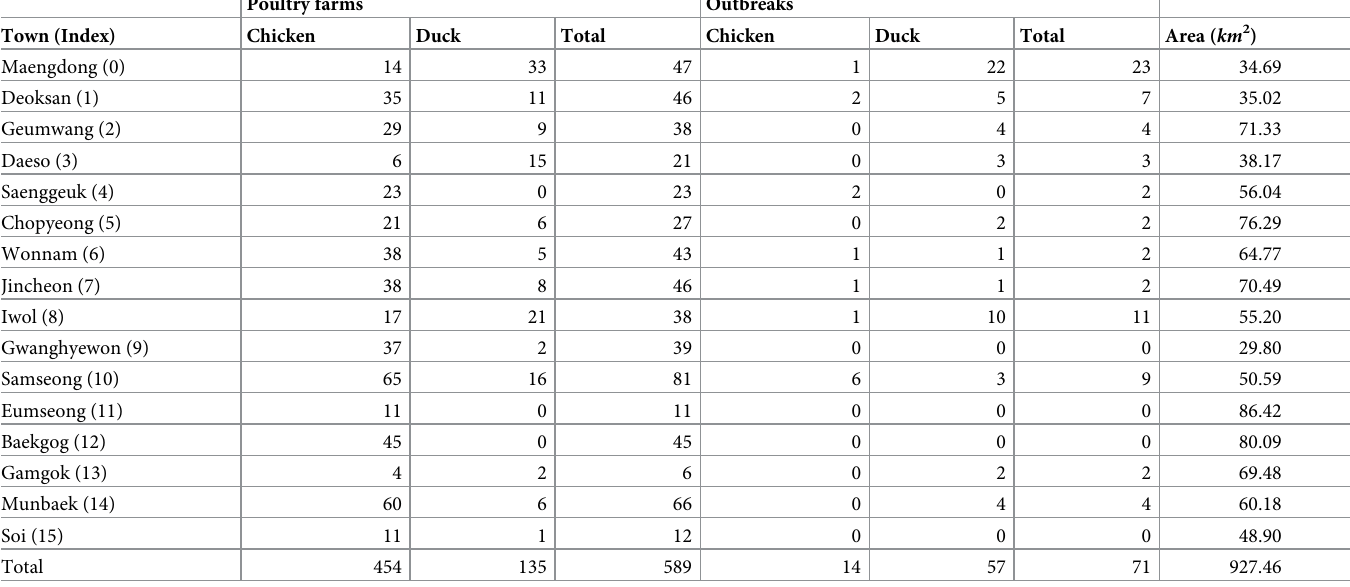
Table 1. Numbers of poultry farms and reported cases of sixteen towns in